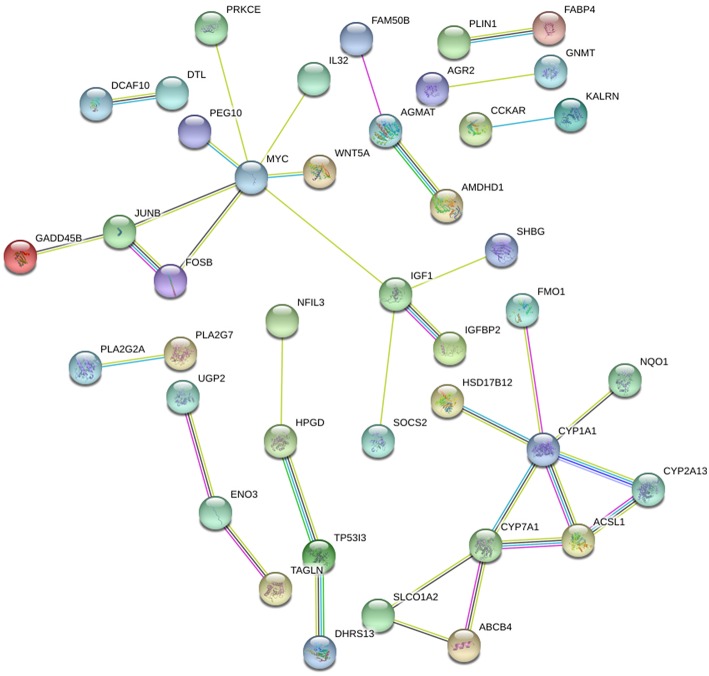
The PPI network of DEGs in NAFLD (STRING). The top 10 genes with most connections included CYP1A1, MYC, CYP7A1, IGF1, JUNB, HPGD, FOSB, ACSL1, ENO3, and CYP2A13.